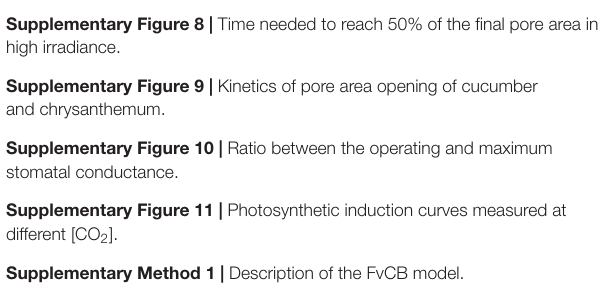
Supplementary Table 2 | Stomatal pore length and guard cell width. Supplementary Table 3 | Correlation coefficients and p -values for all focused traits (provided as a separate excel file). Supplementary Figure 1 | Irradiance fluctuations measured in the greenhouse. Supplementary Figure 2 | Distribution of greenhouse supplemental light. Supplementary Figure 3 | Greenhouse climate conditions during the experiment. Supplementary Figure 4 | Final stomatal conductance reached at low and high irradiance. Supplementary Figure 5 | Dynamics of Rubisco carboxylation rate, electron transport rate, and transient nonstomatal and stomatal limitations during photosynthetic induction. Supplementary Figure 6 | Leaf pigment contents and light absorptance. Supplementary Figure 7 | Relationships between stomatal anatomical traits vs. parameters of stomatal conductance kinetics. Supplementary Figure 8 | Time needed to reach 50% of the final pore area in high irradiance. Supplementary Figure 9 | Kinetics of pore area opening of cucumber and chrysanthemum. Supplementary Figure 10 | Ratio between the operating and maximum stomatal conductance. Supplementary Figure 11 | Photosynthetic induction curves measured at different [CO 2 ]. Supplementary Method 1 | Description of the FvCB model. Supplementary Method 2 | Steps to solve the equation for stomatal pore area. Supplementary Presentation 1 | Comparisons between the measured and predicted leaf net photosynthesis